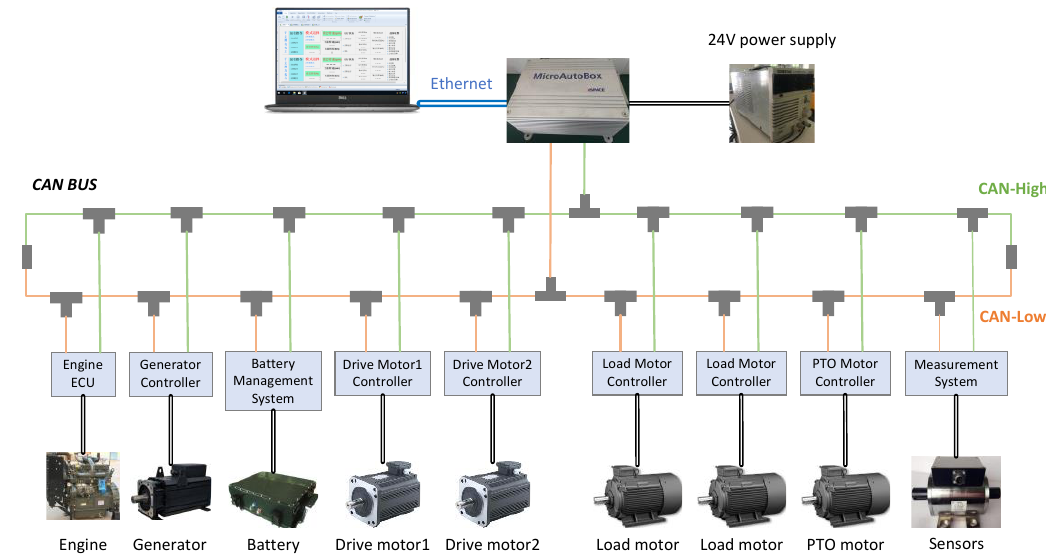
Figure 3. The structure of the control and measurement system for the test platform.